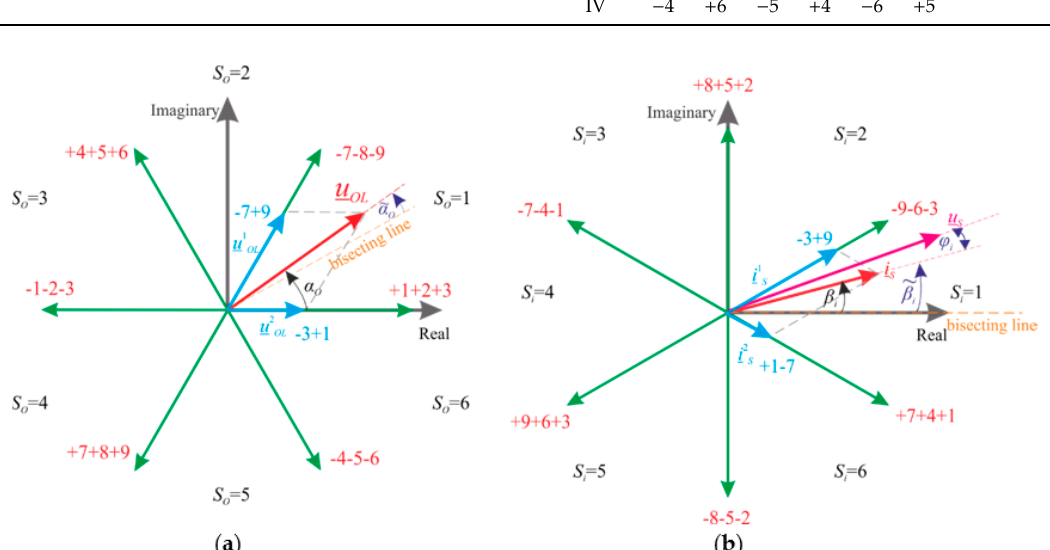
Figure 3. Graphical visualisation of: ( a ) voltage vectors for “active configurations” and description of the synthesis of set output voltage vector u OL ; ( b ) set current vectors for “active configurations” and synthesis description of reference input current vector i S .